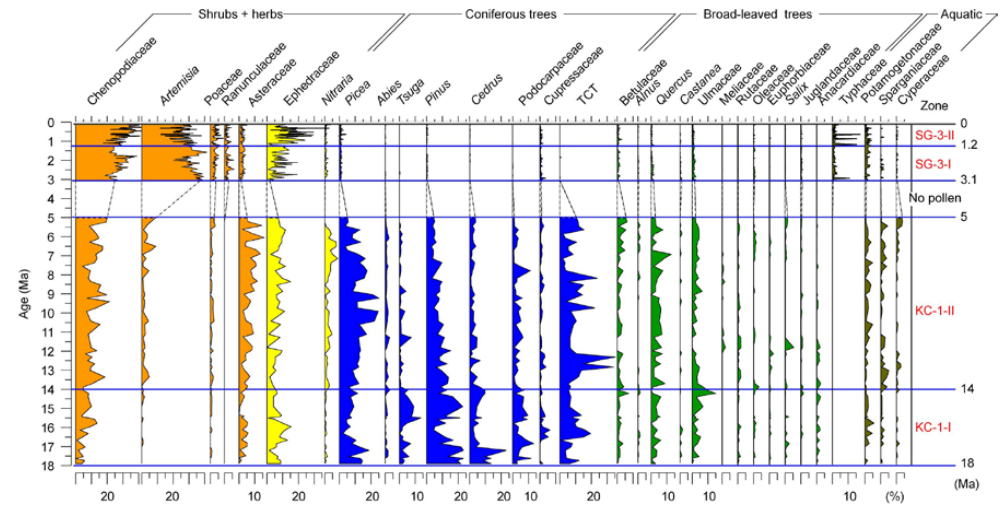
Fig. 5. Late Cenozoic pollen diagram with zones of the KC-1 and SG-3 cores (TCT: Taxodiaceae/Cupressaceae/Taxaceae).